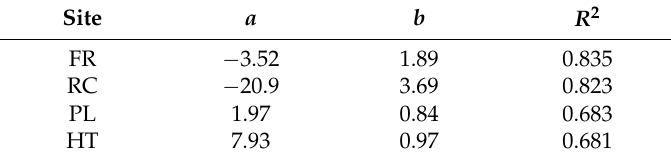
Table 3. Linear regression coefficients for correlation of TSS and turbidity (TSS = f (turbidity) = a + b * turbidity).